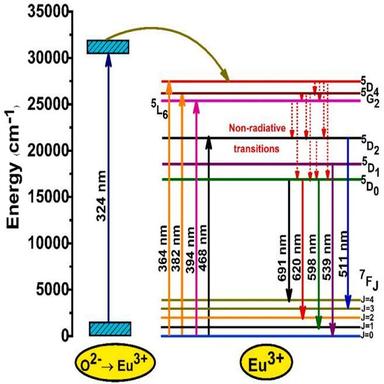
Descriptive energy level diagram displaying distinct electronic transitions with the corresponding wavelength in different energy levels for the Eu3+ - doped Ba2La4Zn2O10 nanophosphor.